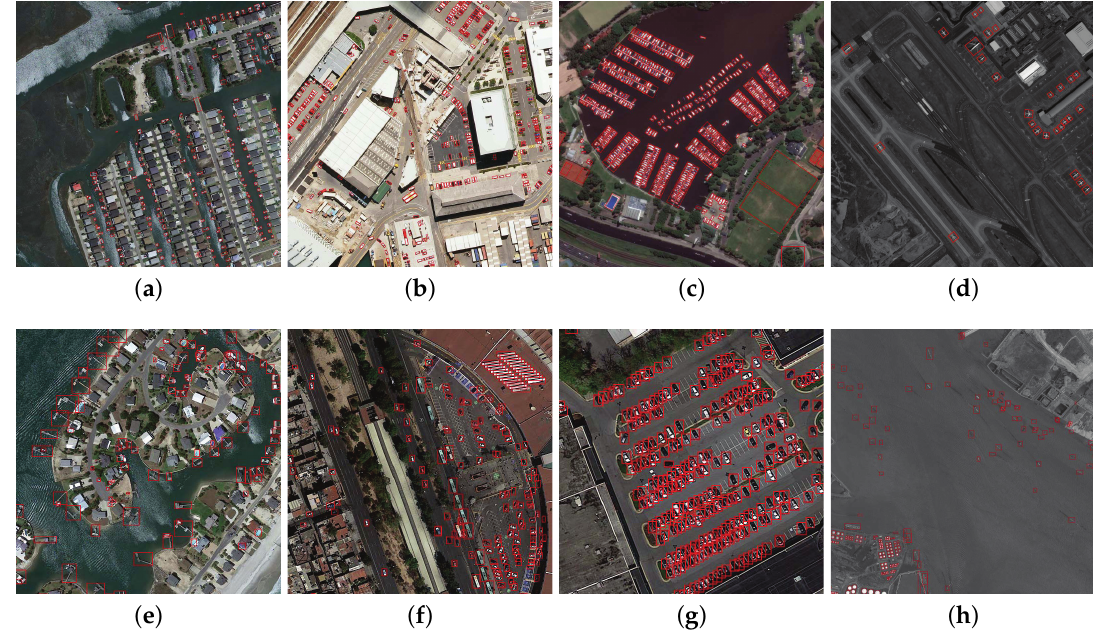
Figure 4. Examples of our detection results for both OBB and HBB tasks on DOTA test set. ( a – d ): OBB task and ( e – h ): HBB